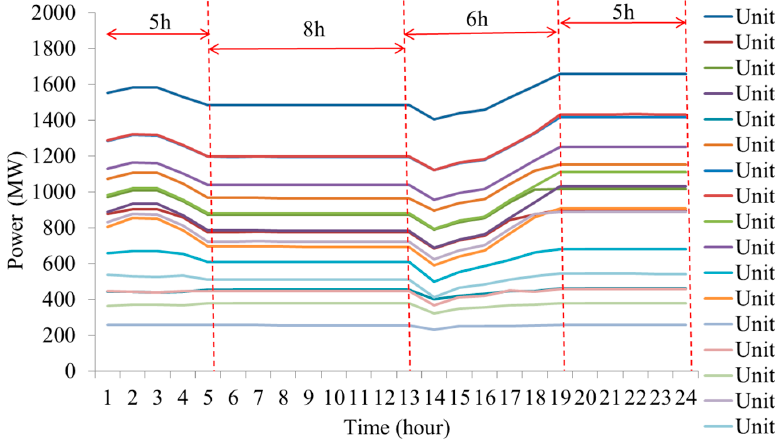
Figure 13. Thermal power outputs in Case 4.